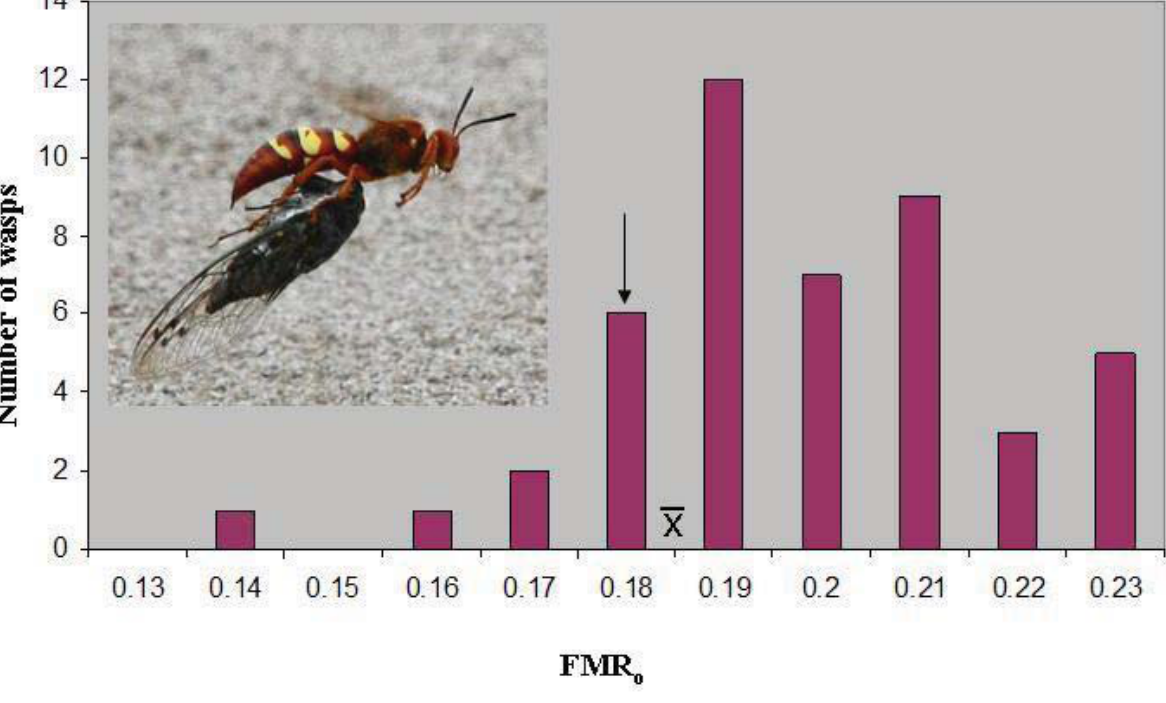
Figure 1. The distribution of operational flight muscle ratios in Sphecius convallis foraging on Tibicen parallelus . The arrow indicates the marginal flight muscle ratio, where vertical take-off is just possible. (cid:2) indicates the mean. Inset: Pacific cicada killer female carrying cicada in